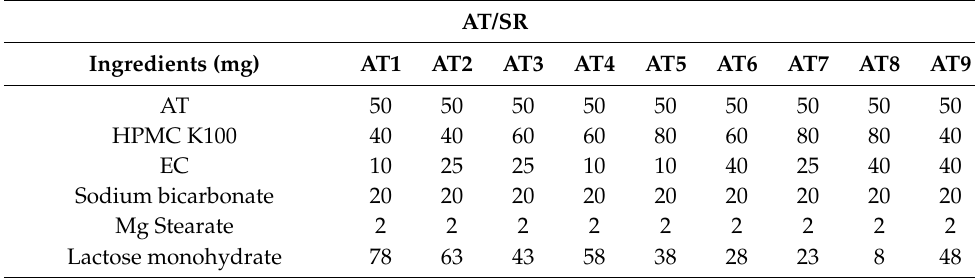
Table 3. Composition of different AT/SR mono tablets.